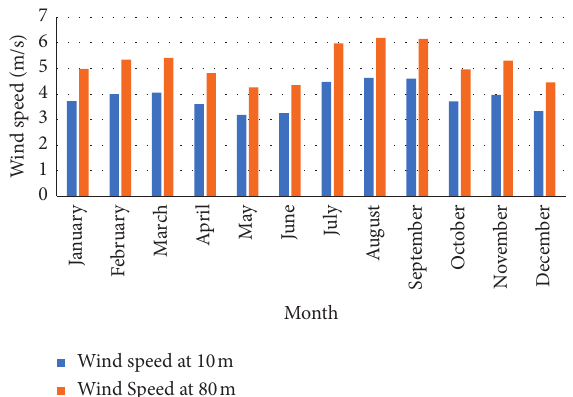
Figure 6: Monthly wind speed of Doderkope at 10 m and 80m.